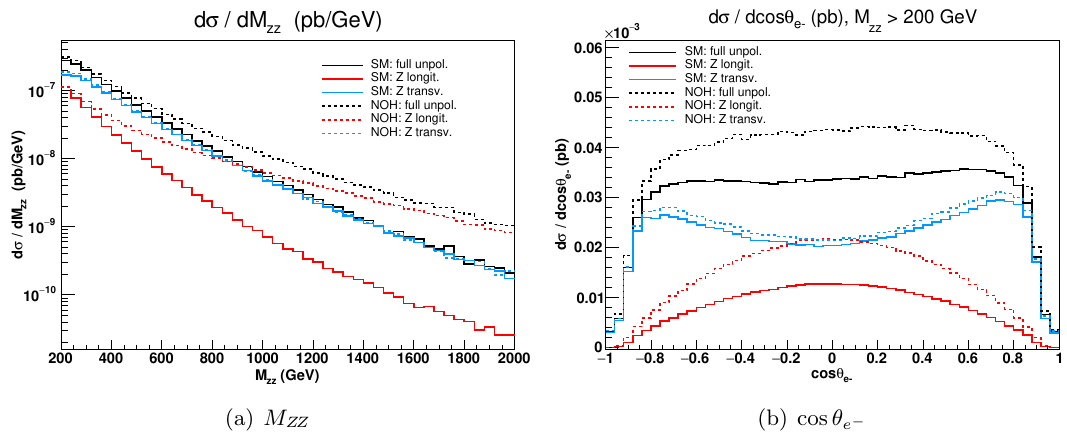
Figure 13 . ZZ scattering: comparison of Standard Model (solid) and Higgsless model (dashed) distributions in M ZZ and cos (cid:18) , in the (cid:12)ducial region ( M ZZ > 200 GeV). The full set of kinematic e (cid:0) cuts (see section 4.1) is